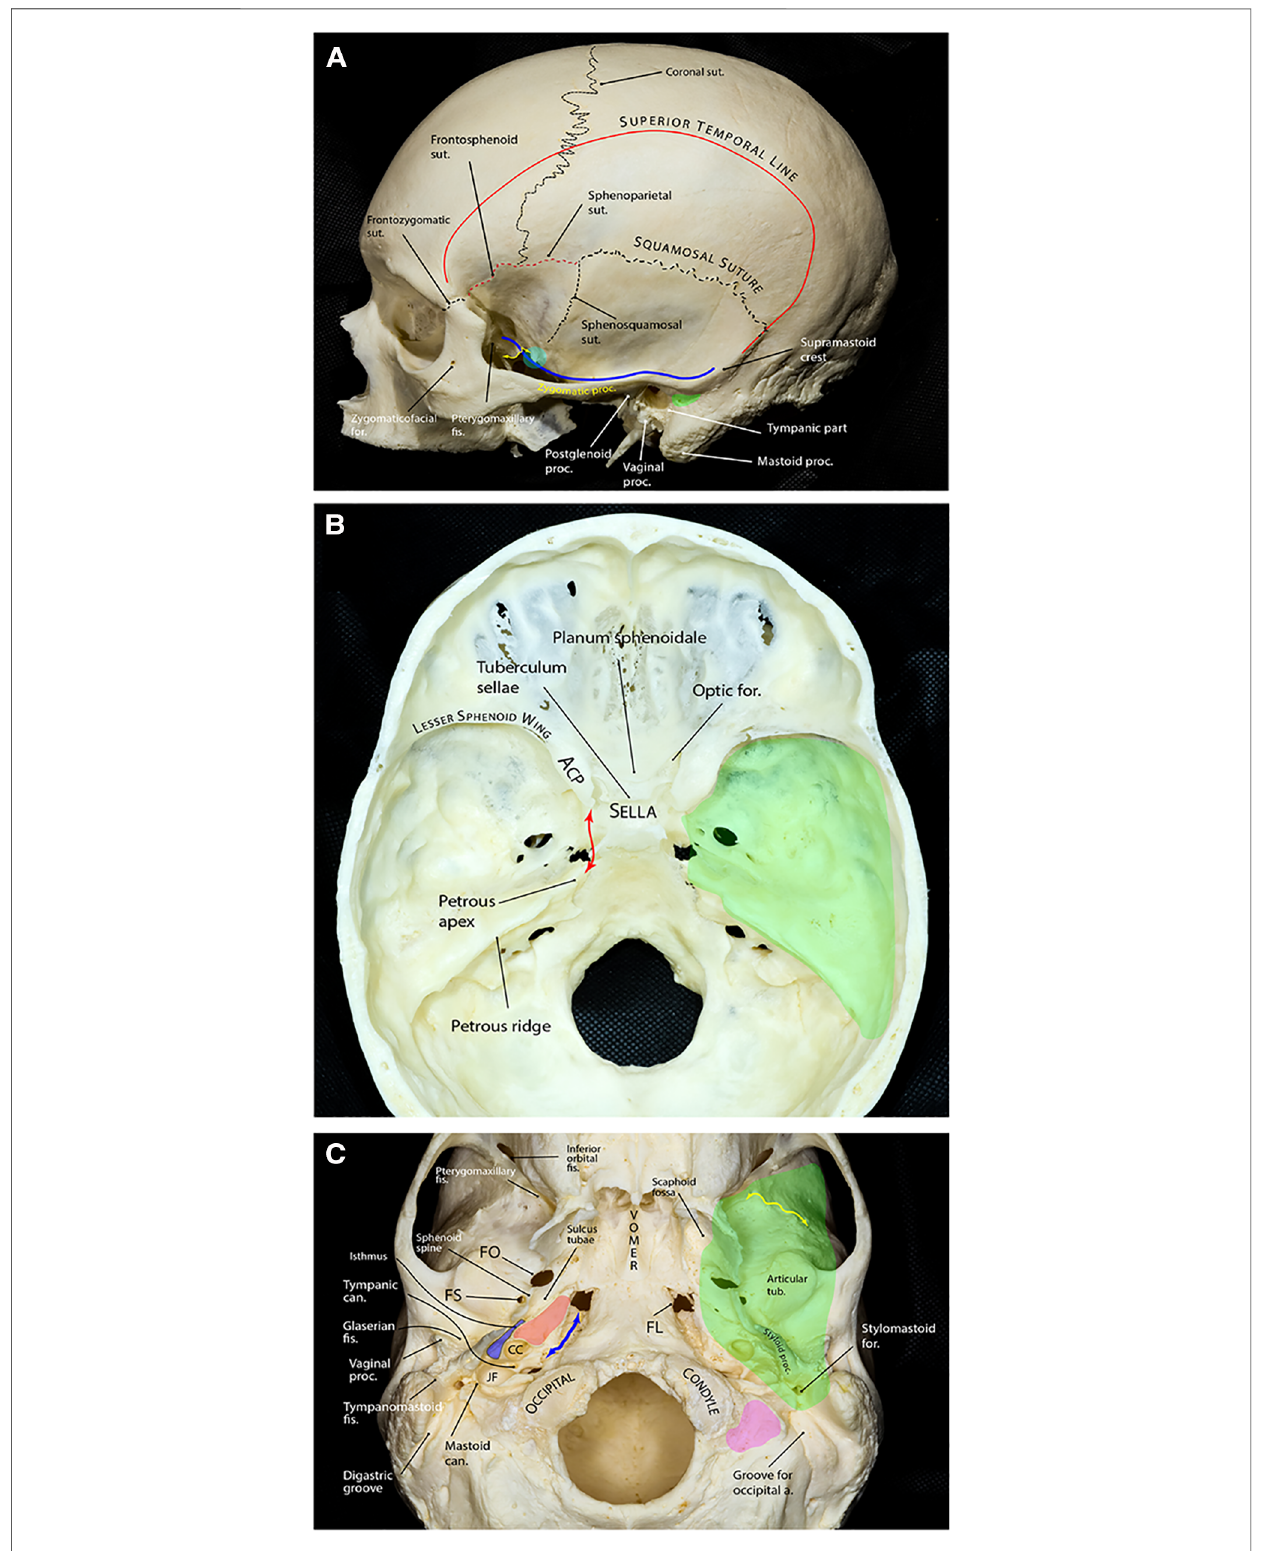
FIGURE 1 Bony anatomy of the middle fossa. ( A ) Lateral view of skull showing relevant osseous landmarks for middle fossa surgery. Superior temporal line is the line of attachment of the temporalis muscle. The greater sphenoid wing and the temporal squama slope laterally and superiorly from the middle cranial fossa. The blue line shows the contour of the middle fossa fl oor projected on the lateral skull surface. The fl oor is almost at the level of the zygomatic arch. The fl oor ascends posteriorly and is approximately at the level of the supramastoid crest, which continues as the superior temporal line. At the level of the supramastoid crest, the middle fossa is separated from the tympanic cavity by the tegmen tympani. The suprameatal (aka McEwen) triangle (green area) lies just inferior to the supramastoid crest and posterosuperior to the external auditory canal and is the gateway to the mastoid antrum during mastoidectomy. Further anteriorly, the middle fossa fl oor is composed of the greater wing of the sphenoid that makes the roof of the